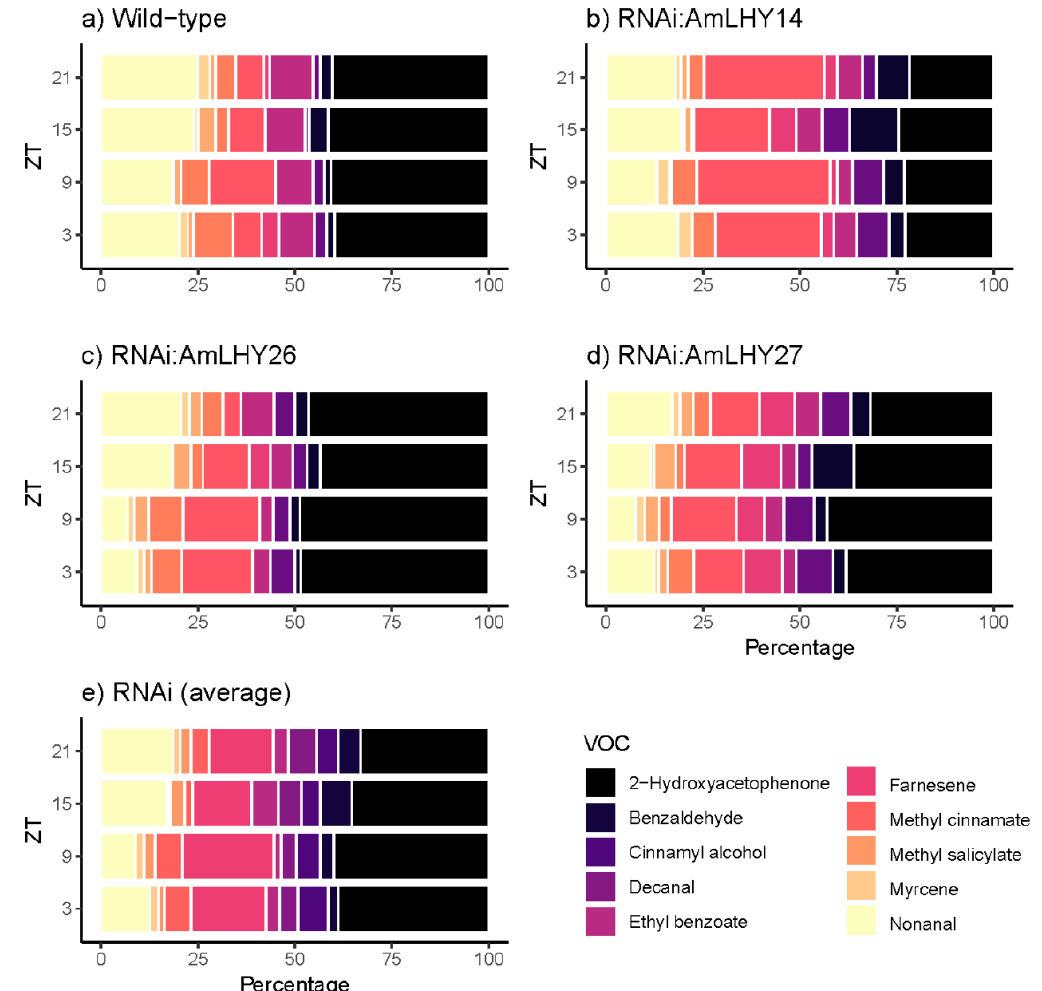
Figure 4. Daily scent emission of minor compounds in wild type ( a ), and transgenic lines Figure4. Dailyscentemissionofminorcompoundsinwildtype( a ), andtransgeniclines RNAi:AmLHY14 RNAi:AmLHY14 ( b ), RNAi:AmLHY26 ( c ), RNAi:AmLHY27 ( d ). An average of RNAi lines is ( b ), RNAi:AmLHY26 ( c ), RNAi:AmLHY27 ( d ). An average of RNAi lines is represented in ( e ). ZT represented in ( e ). ZT indicates zeitgeber time. indicates zeitgeber